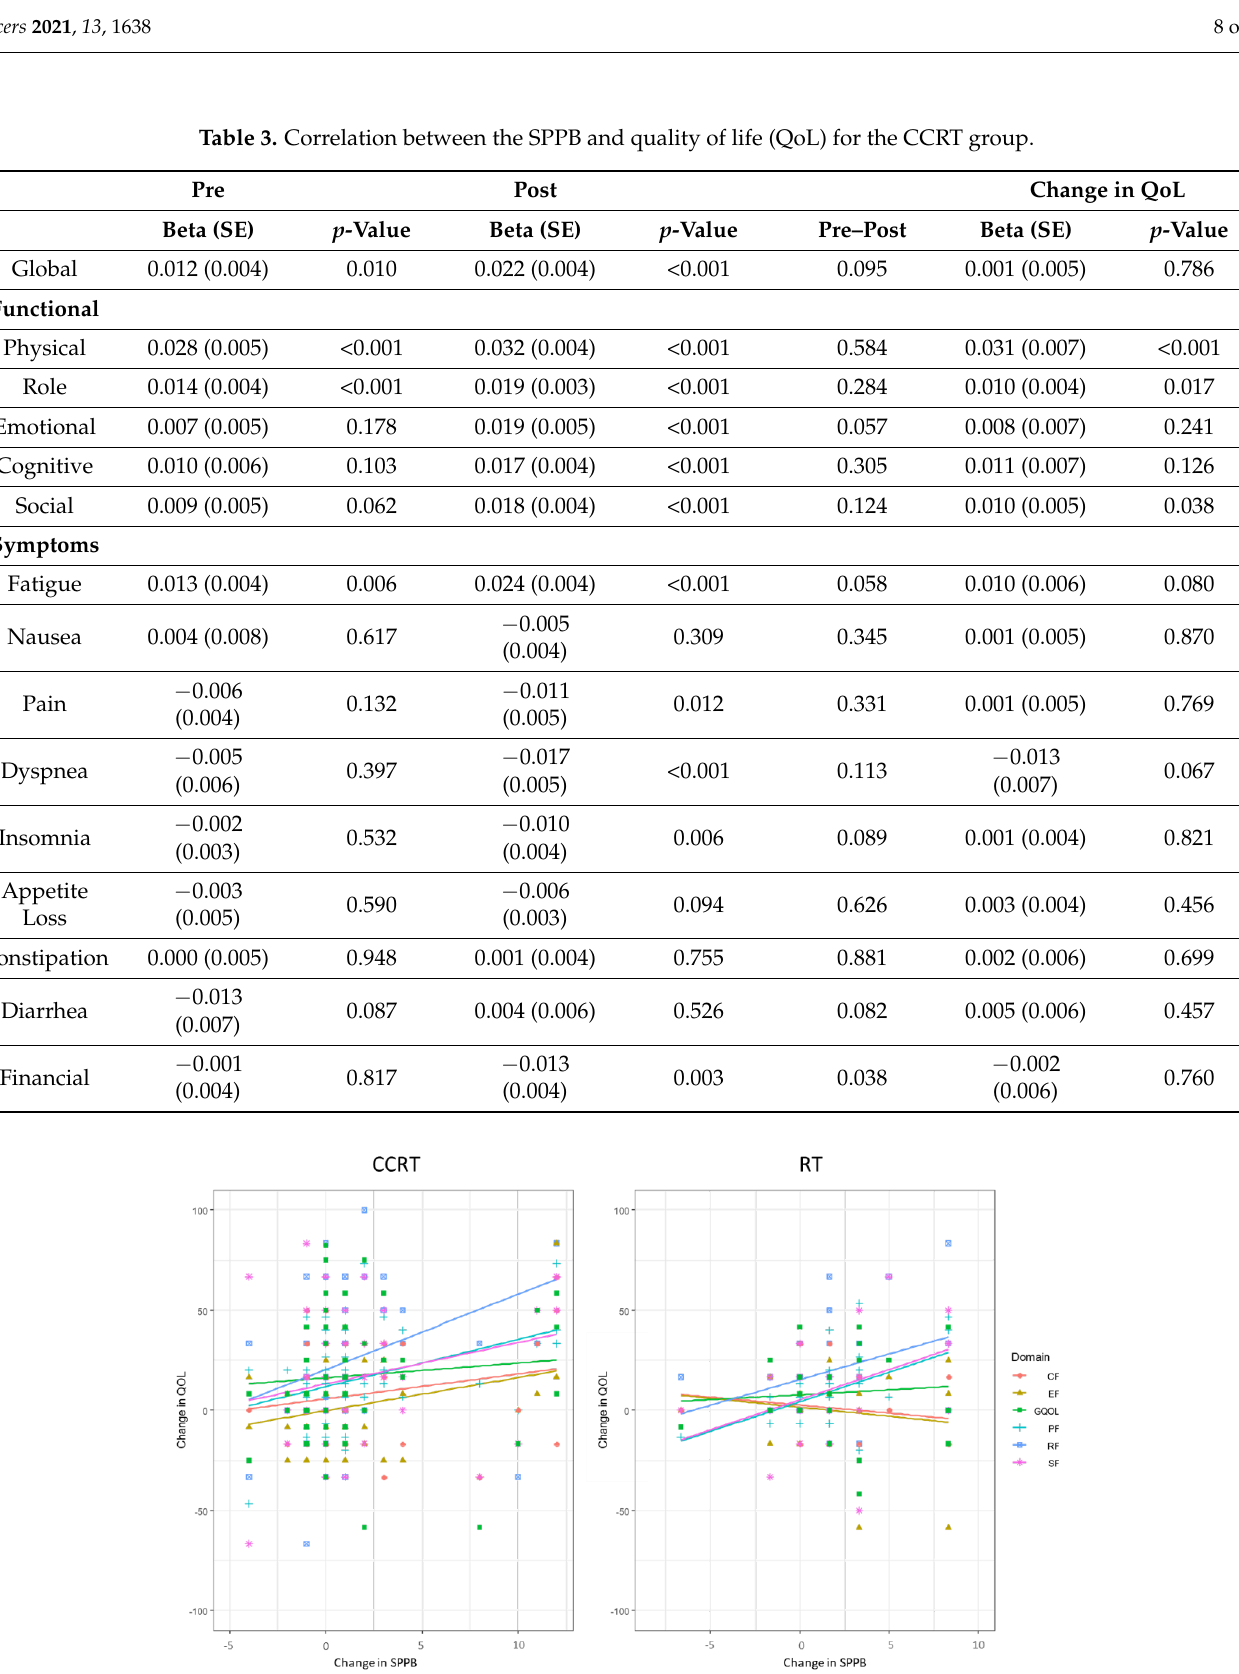
Figure 2. Correlation between the change in physical functional and global QOL and SPPB for patients who received CCRT or radiation alone (RT). CF = cognitive function, EF = emotional function, GQOL = global quality of life, PF = physical function, RF = role physical function, and SF = social function.